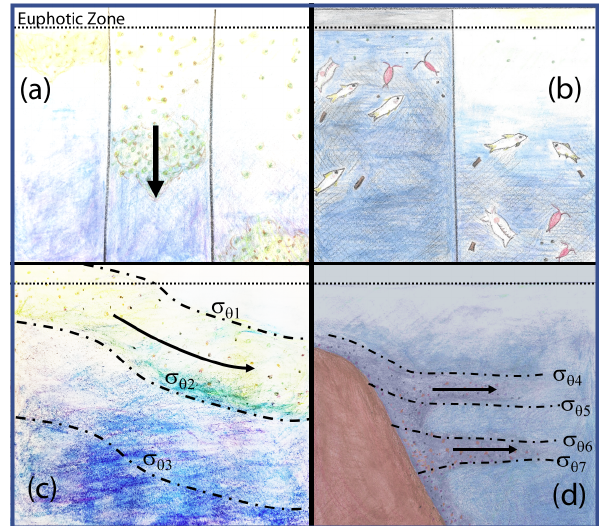
Figure 18. Four mechanisms that can lead to non-classical particle flux profiles. (a) Temporal delay (Giering et al., 2017), (b) vertical migration (Turner, 2015; Bishop et al., 2016), (c) physical subduc- tion (Omand et al., 2015; Stukel et al., 2018), and (d) sediment re- suspension and lateral advection (Alonso-González et al., 2009; Pak et al., 1980; McPhee-Shaw et al., 2004; Chase et al.,